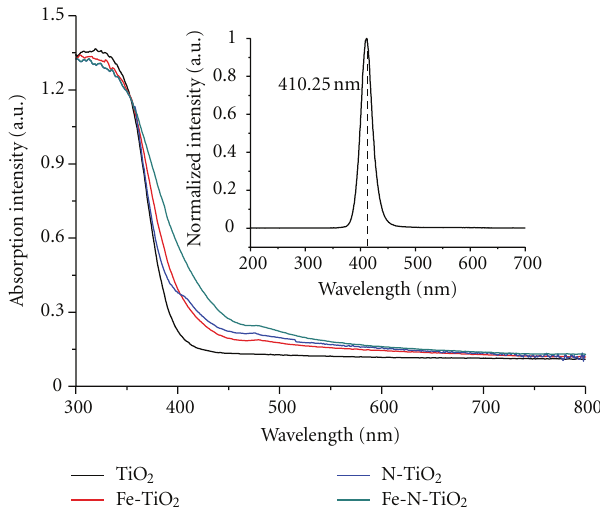
Figure 3: The UV-vis absorption spectra of TiO 2 with di ff erent doping. Inset is the normalized emission spectra of the blue LEDs.